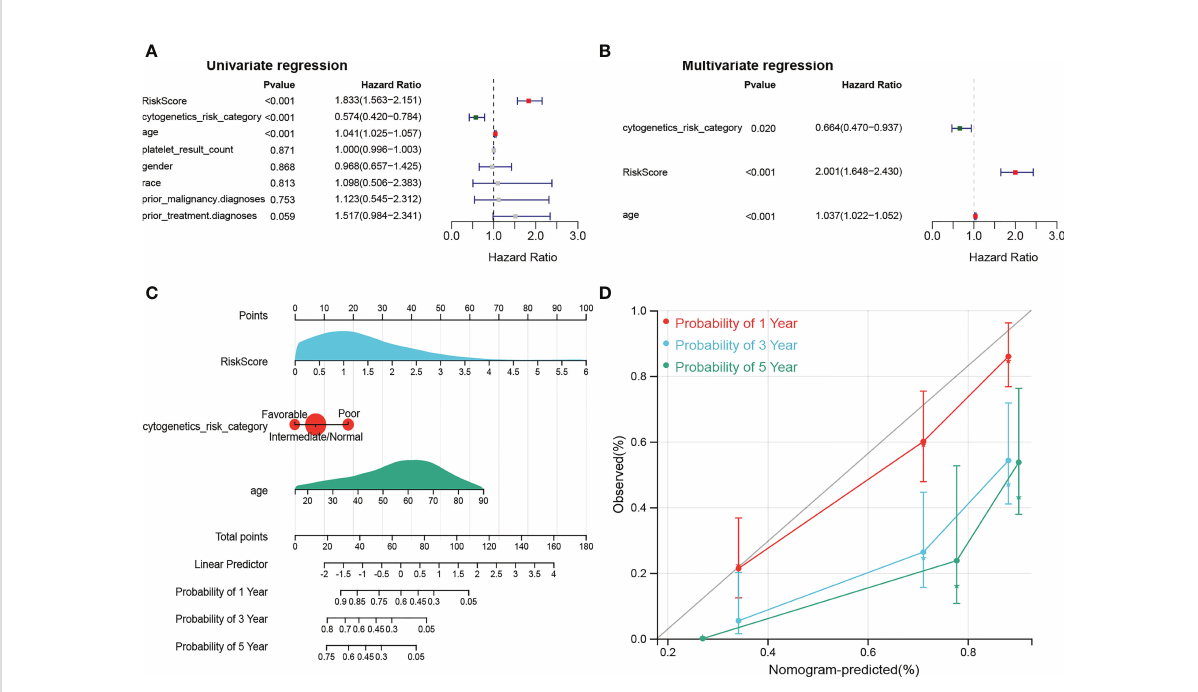
FIGURE 5 denti fi cation of independent prognostic factors. (A, B) Outcomes for the univariate and multivariate Cox regression analysis of clinical parameters in AML patients ( p < 0.05). (C) Nomogram of 1-, 3- and 5- year OS for AML patients. (D) Calibration plot of 1-, 3- and 5- year OS associated